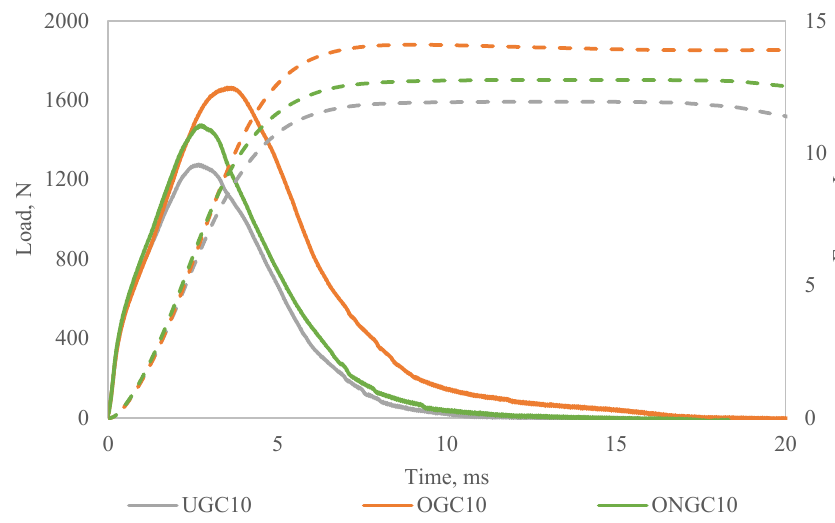
Figure 6. Load-Energy-Time graph of impact test for UGC, OGC and ONGC.